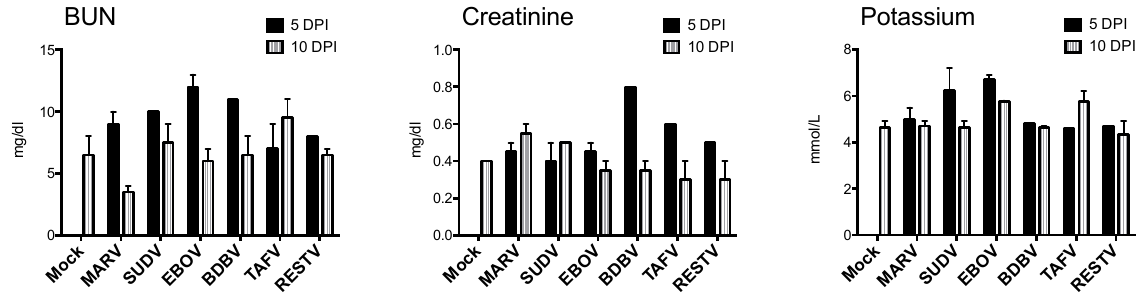
Figure 1. Blood chemistry measurements for bats inoculated with six different filoviruses in the pilot study and euthanized at 5 and 10 days post inoculation (DPI). Mock = mock-inoculated controls, MARV = Marburg virus, SUDV = Sudan virus, EBOV = Ebola virus, BDBV = Bundibugyo virus, TAFV = Taï Forest virus, and RESTV = Reston virus. ALT = alanine aminotransferase, AST = aspartate aminotransferase, ALP = alkaline phosphatase, ALB = albumin, BUN = blood urea nitrogen.